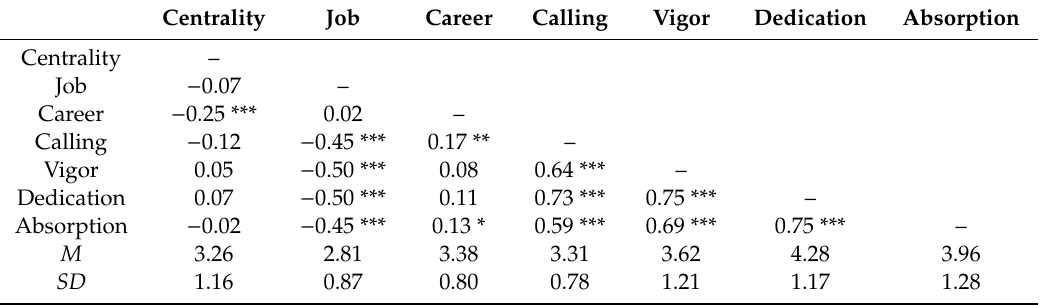
Table 1. Descriptive statistics and bivariate correlations between the variables included in the study. Centrality Job Career Calling Vigor Dedication